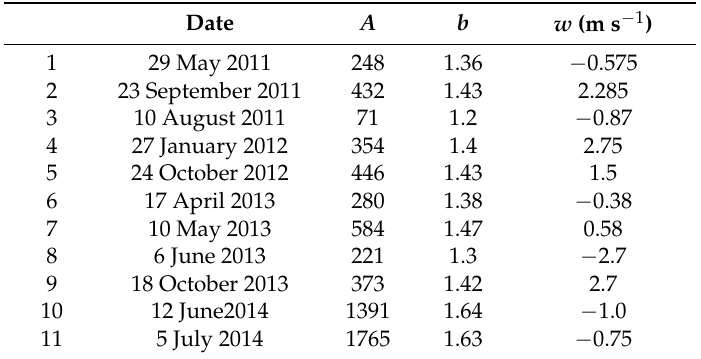
Table 1. Eleven selected days for correlating ECMWF vertical wind w to disdrometer derived A-b parameters. The w value is the running accumulative average of the vertical wind speed, evaluated at an altitude of 10,000